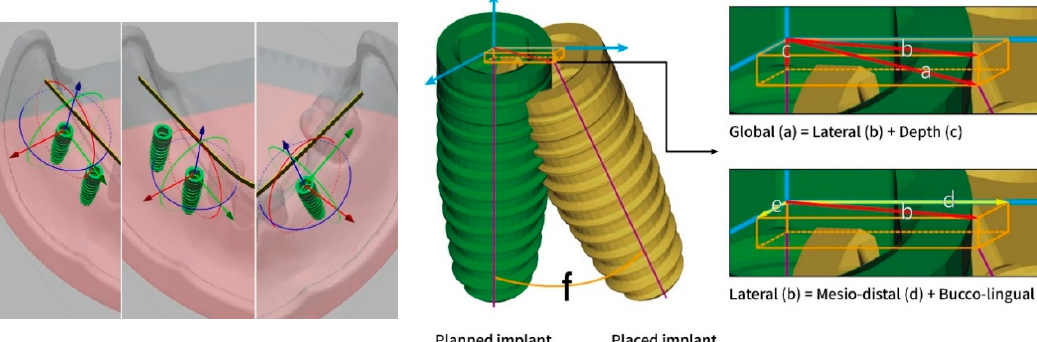
Figure 5. The coordinate systems of each implant site (left) were created according to the longitudinal axis and the designated buccal direction of the planned implants. Deviations of measurement at the implant platform were defined as: (a) global deviation, (b) lateral deviation, (c) depth deviation, (d) mesio-distal deviation, (e) bucco-lingual deviation, and (f) angular deviation. The deviations at the implant apex were defined and measured by the same coordinate system of each implant site.